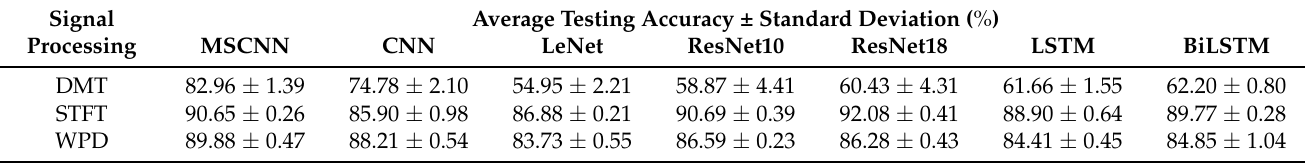
Table 7. Experimental results of the spindle datasets.